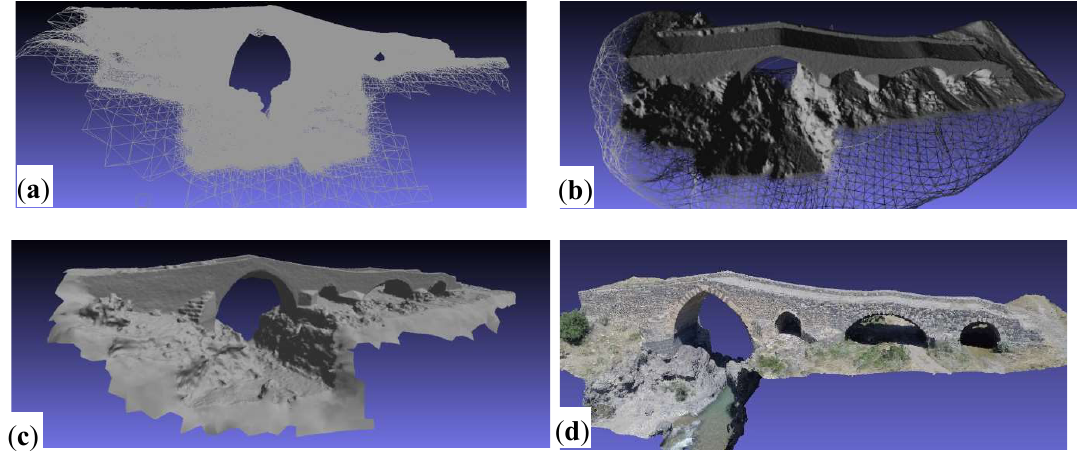
Figure 10. Surface reconstruction: ( a ) polygonal mesh of surfaces; ( b ) polygonal mesh visualized with shade; ( c ) nurbs surface; ( d ) mapped texture surface.